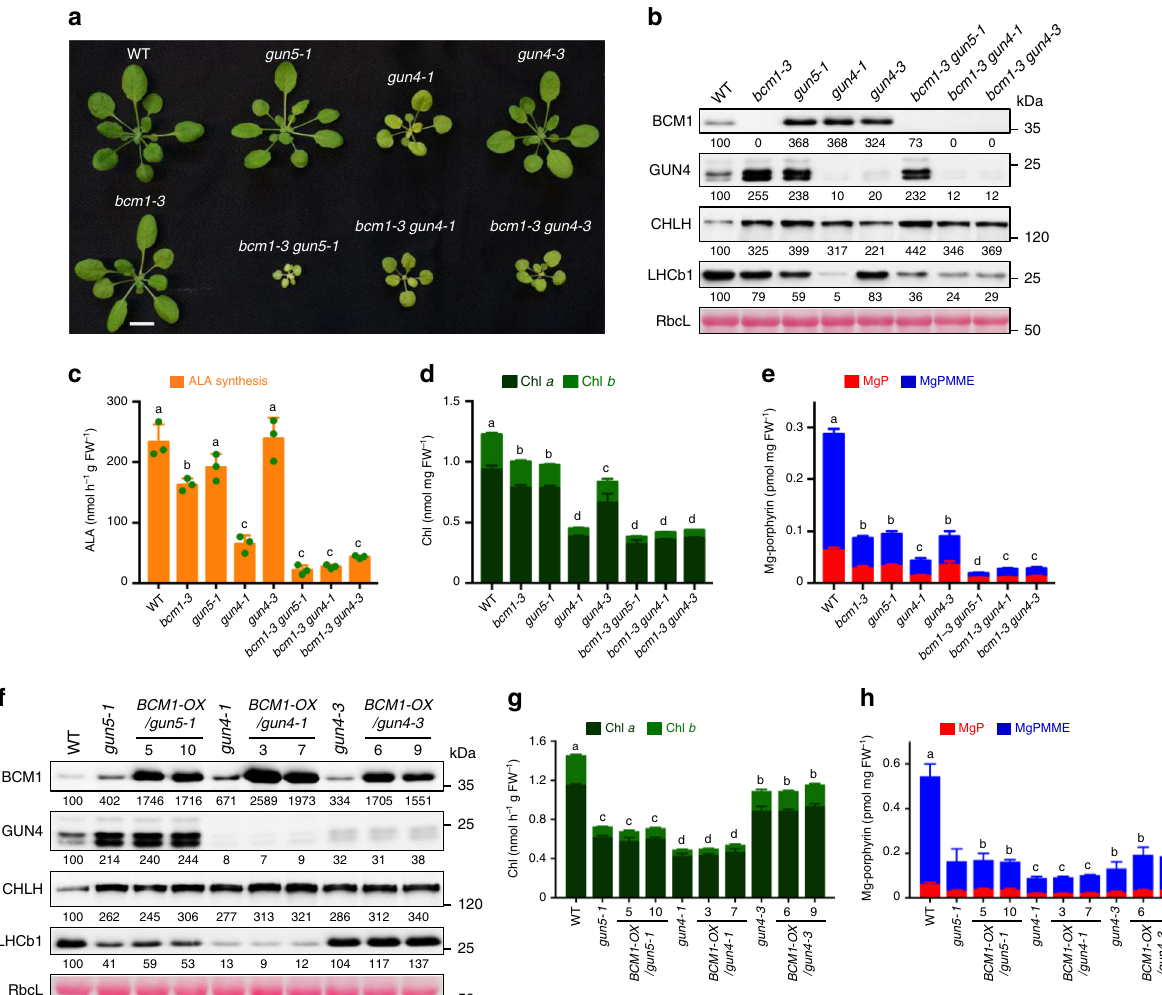
Fig. 3 Genetic interaction between BCM1 and MgCh. a Representative images of 28-day-old WT, bcm1-3 , gun5-1 , gun4-1 , gun4-3 , bcm1-3 gun5-1 , bcm1-3 gun4-1 , and bcm1-3 gun4-3 seedlings grown under short-day low light (70 μ mol photon m − 2 s − 1 ) conditions. Scale bar, 1 cm. b Steady-state levels of the indicated proteins in the seedlings depicted in a were determined by immunoblotting using the indicated antibodies. c – e ALA synthesis rate ( c ) and levels of Chl ( d ) and Mg-porphyrin ( e ) in the seedlings shown in a . f Steady-state levels of the indicated proteins in 21-day-old WT, gun5-1 , BCM1-OX/gun5-1 , gun4-1 , BCM1-OX/gun4-1 , gun4-3 , and BCM1-OX/gun4-3 seedlings grown under the same conditions as in a were determined by immunoblotting using the indicated antibodies. g , h Levels of Chl ( g ) and Mg-porphyrins ( h ) in seedlings analyzed in f . In c – e , g , h , error bars represent SD of three biological replicates. Letters above histograms indicate signi fi cant differences determined by Tukey ’ s HSD method ( P < 0.05). In b , f , Ponceau S-stained membrane strips bearing RbcL were used as loading controls. Numbers below immunoblots represent normalized protein abundances relative to WT